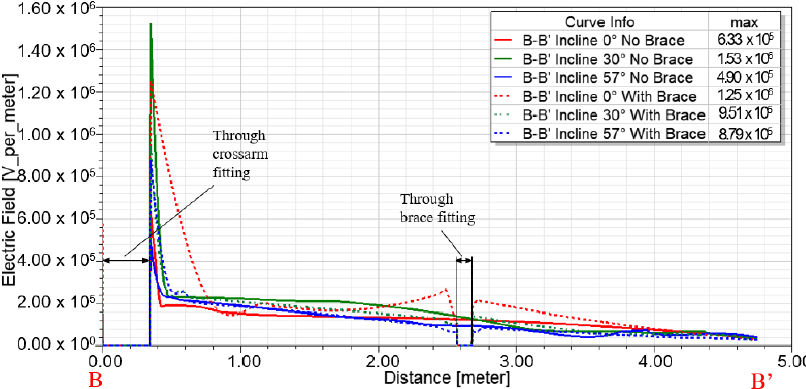
Figure 18. E-Field distribution for the case with a 57° inclined insulator.